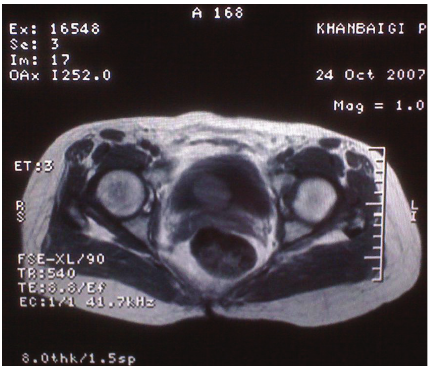
Figure 3: A well-defined 3 × 4 centimeter intramural mass was shown in